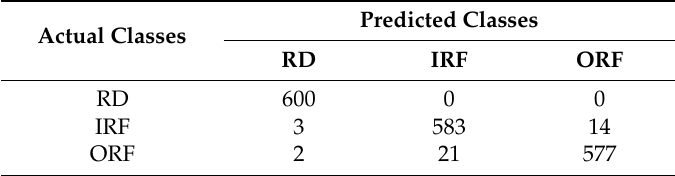
Table 2. Confusion matrix of the multiclass SVM ensemble classifier resulting from the testing dataset.